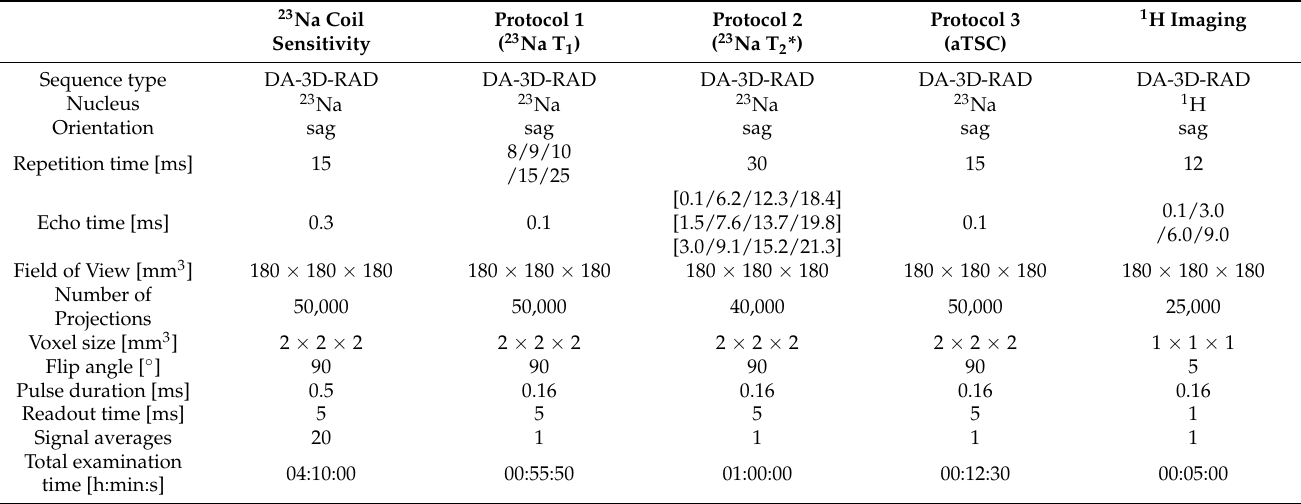
Table 4. Parameters of the DA-3D-RAD sequence used for imaging with the dual-tuned 23 Na/ 1 H surface coil. Protocol 1 Protocol 2 Protocol